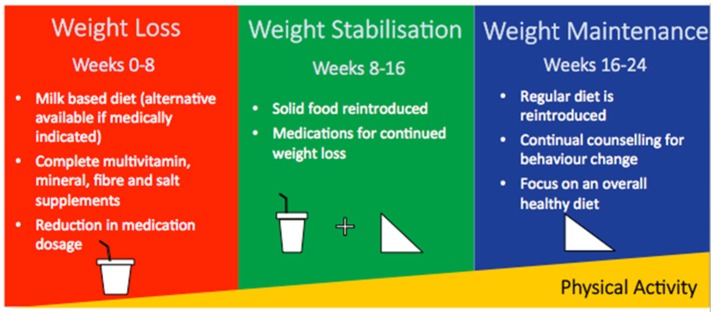
Overview of the 3 phases within the 24-week intensive weight management programme.